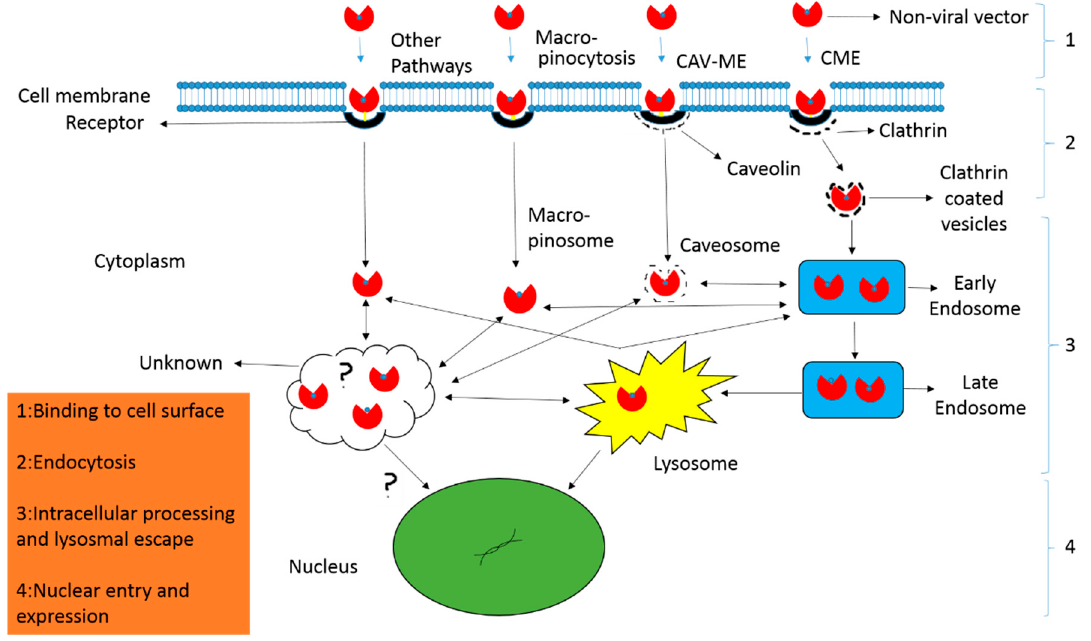
Figure 3. Mechanism of non-viral vector delivery. ( 1 ) The nanocarriers have to overcome extracellular barriers to reach and bind with cell surfaces either directly or following processing along filopodia.